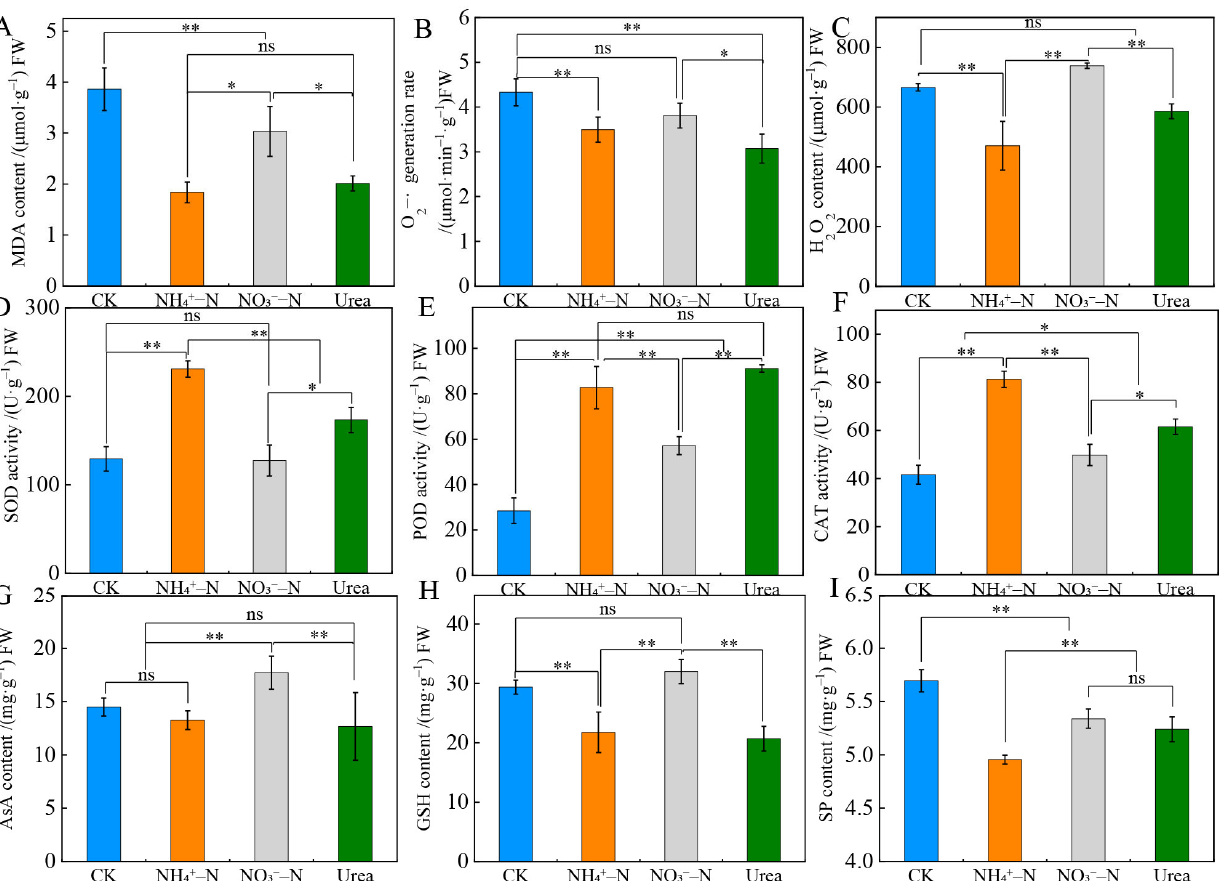
Figure 3. Changes in root physiology and antioxidant indicators with different N forms. The MDA ( A ), H 2 O 2 ( C ), AsA ( G ), GSH ( H ) and SP ( I ) levels. O 2 ·− generation rate of ( B ). Activities of SOD ( D ), POD ( E ) and CAT ( F ). MDA, malondialdehyde; O 2· − , superoxide anion radical; H 2 O 2 , hydrogen peroxide; SOD, superoxide dismutase; POD, peroxidase; CAT, catalase; AsA, ascorbic acid; GSH, reduced glutathione; SP, soluble protein. The data indicated are the means ± SDs ( n = 3). Different le tt ers show signi fi cant di ff erences between treatments (** p < 0.01, * p < 0.05).